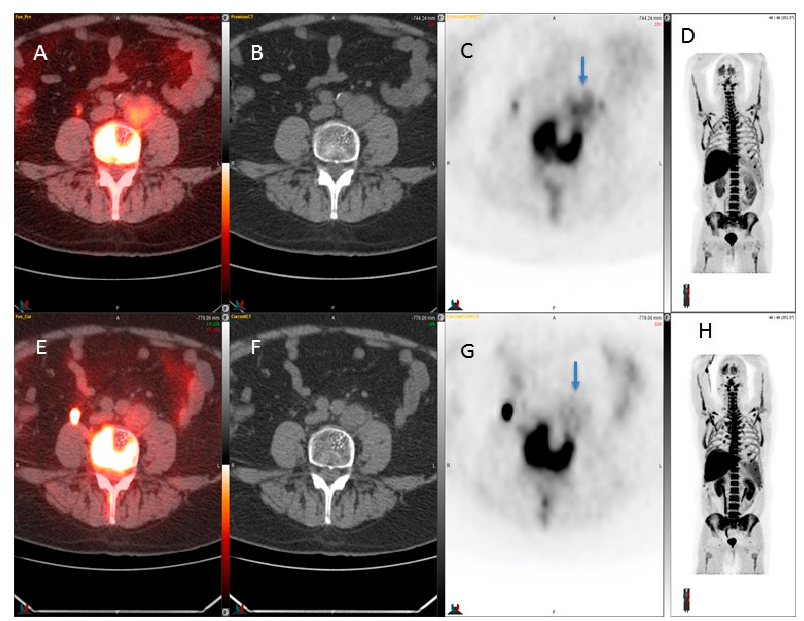
Figure 2. 18 F-FLT used for detection of retroperitoneal lymph node metastases before and after chemotherapy. A weak response was seen while the SUVmax value decreased from 4.1 to 2.1 in the left common iliac node (arrows in C and G ). Upper row, baseline: from the left fusion image ( A ), CT image ( B ), 18 F-FLT PET image ( C ), and MIP image ( D ); lower row, after 4 week therapy: from the left fusion image ( E ), CT image ( F ), 18 F-FLT PET image ( G ), and MIP image ( H ). Color bar range from 0 to 5.